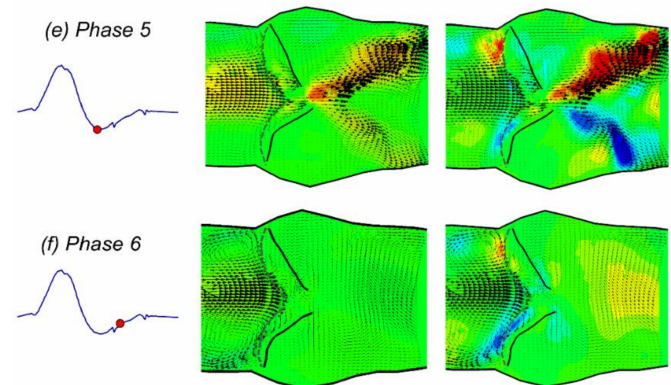
Figure 5. Contours of PIV phase-averaged velocity in x and y directions.